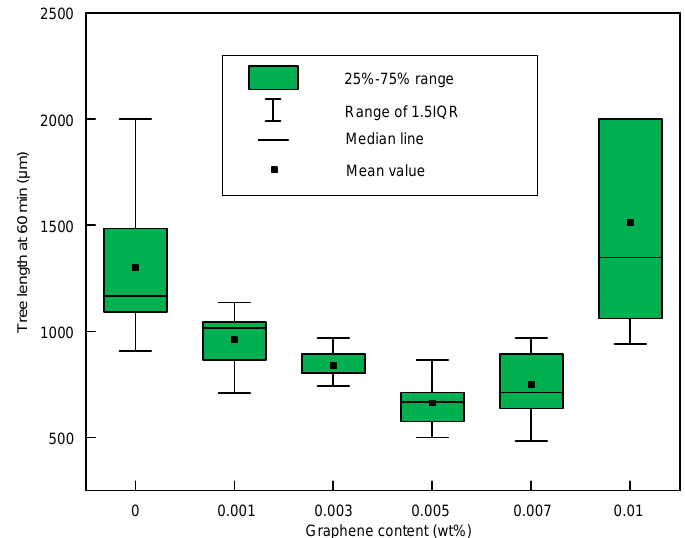
ff erent graphene